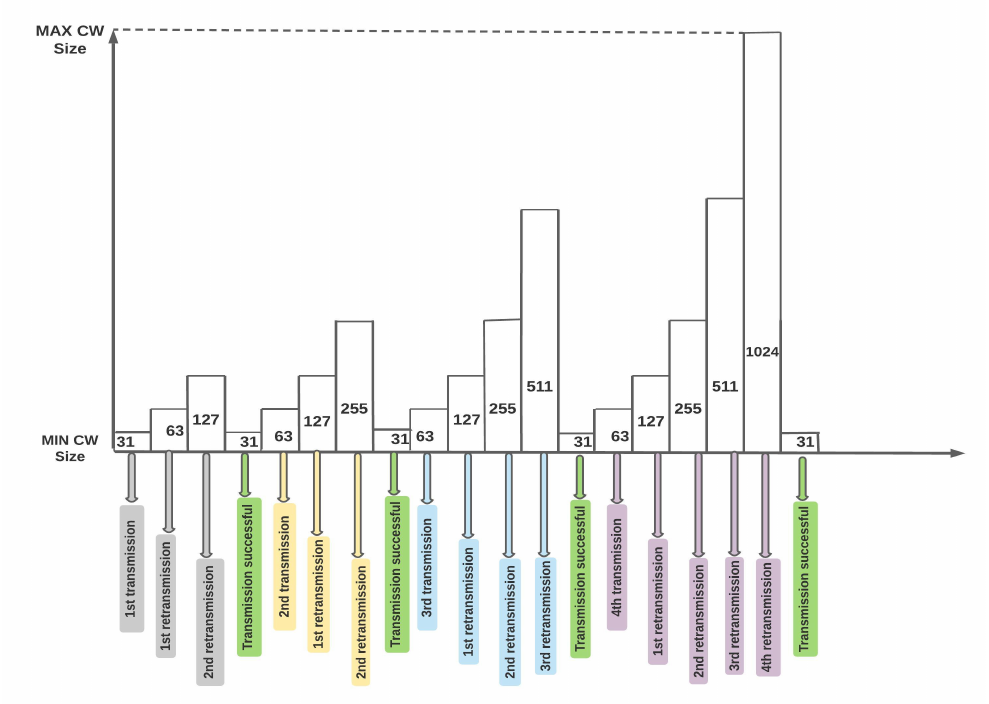
Figure 1. Variation in the size of CW due to collision and successful